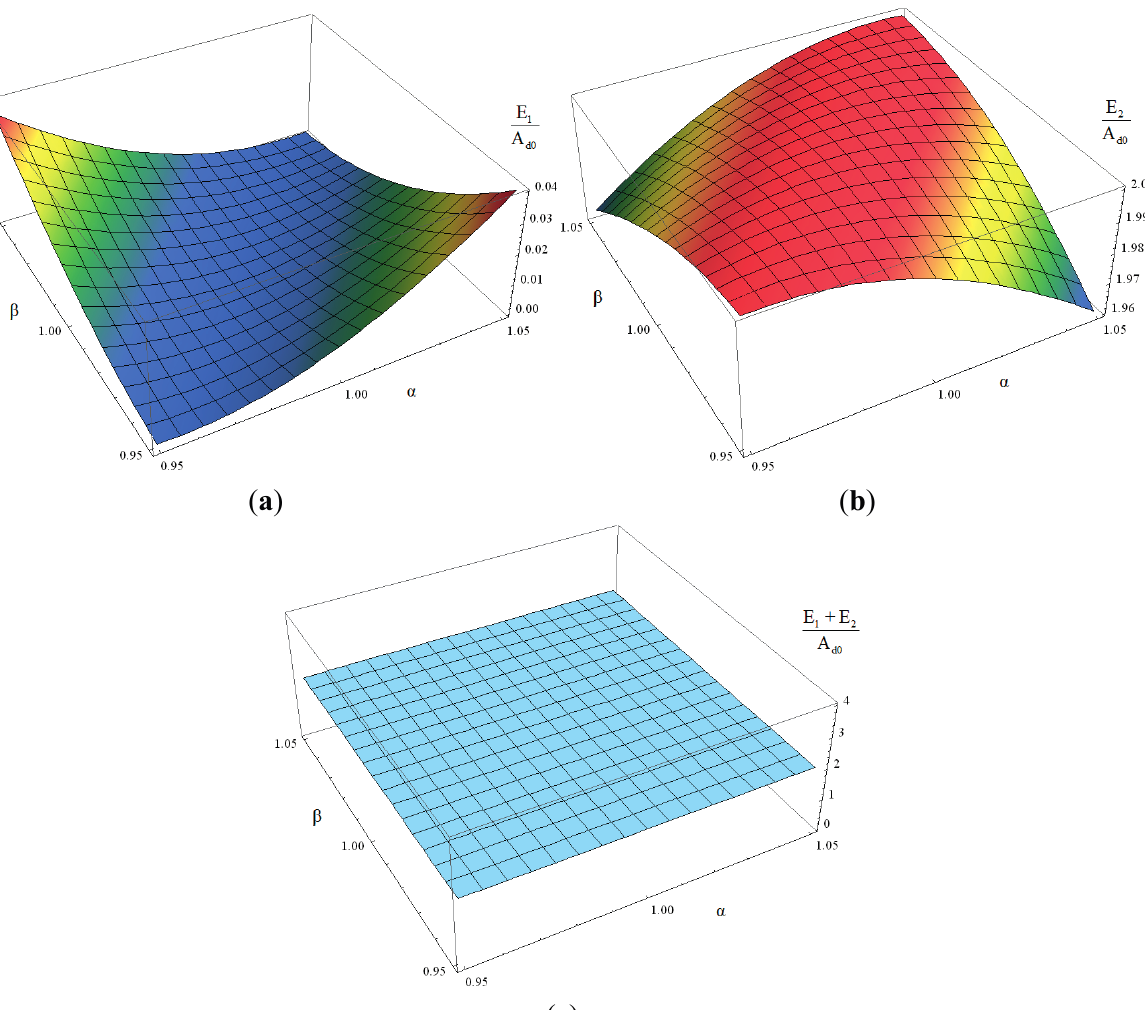
Figure 4. ( a ) Change of E variation of α and β ; ( c ) Change of (E